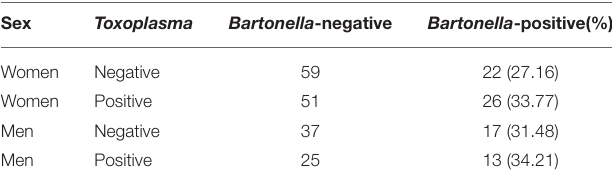
TABLE 1 | Seroprevalence of bartonellosis in Toxoplasma -seronegative and Toxoplasma -seropositive subjects.